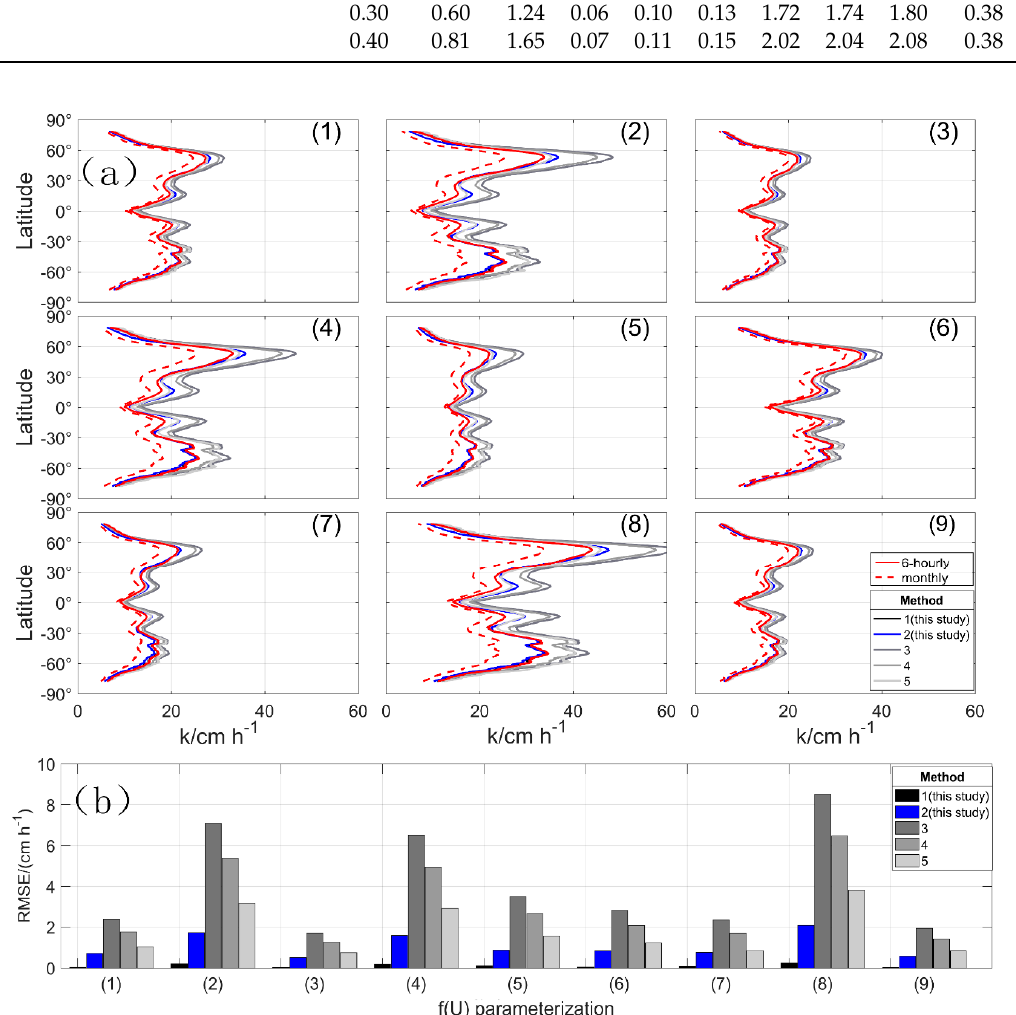
Figure 7. ( a ) Zonal profiles of corrected k for CO 2 using the five correction methodologies in comparison to annual k derived from 6-hourly (red solid curve) and monthly (red dashed curve) wind speed. Zonal variation in k estimated using method 1 (in black) is not visible because it overlaps with the 6-hourly k. Panels ( a1 – a9 ) show the latitudinal variations in nine k parameterizations listed in Table 1. ( b ) The RMSE of each method in corrected k from 6-hourly